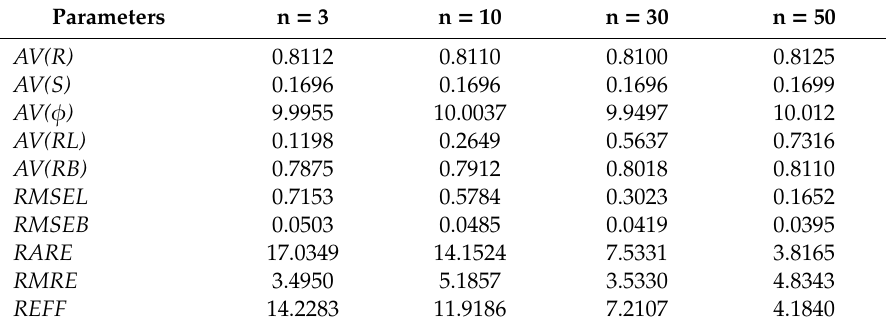
Table 8. Simulation results for cases